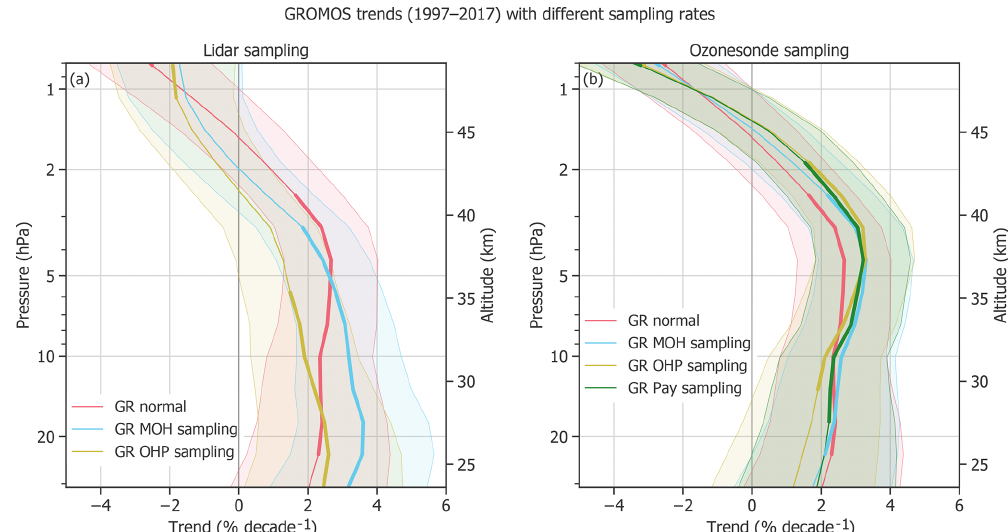
Figure 8. GROMOS (GR) trends from January 1997 to December 2017 using its high temporal resolution (normal data set with correction for anomalies) as well as the temporal sampling rate of the different lidars (a) and ozonesondes (b) . The shaded areas show the 2 σ uncertainties, and bold lines identify trends that are significantly different from